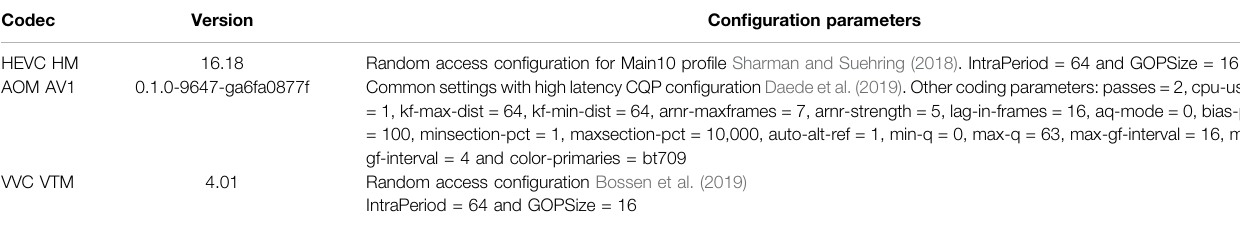
TABLE 3 | The software versions and con fi gurations of the evaluated video